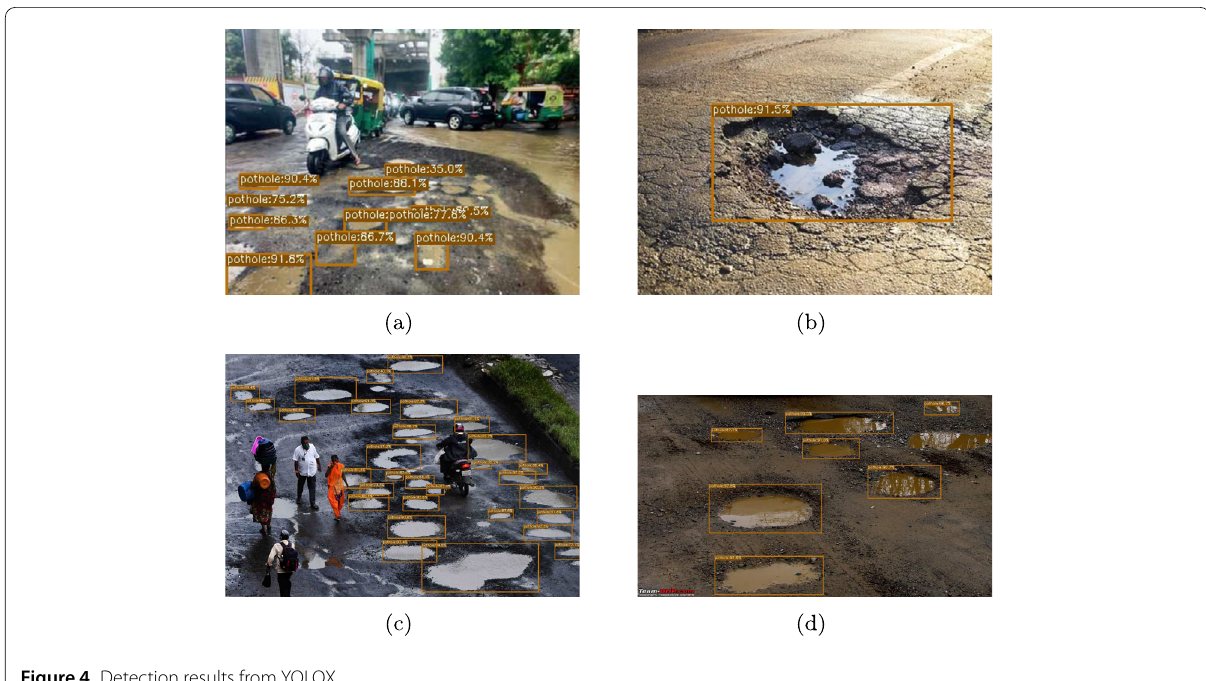
Figure 4 Detection results from YOLOX